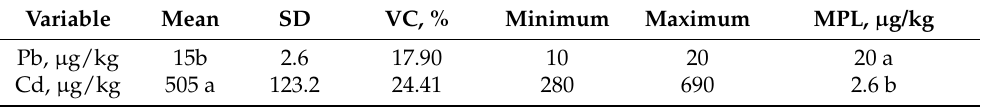
Table 3. The concentration of Pb and Cd in milk and comparison with MPLs for whole milk (n = 40).